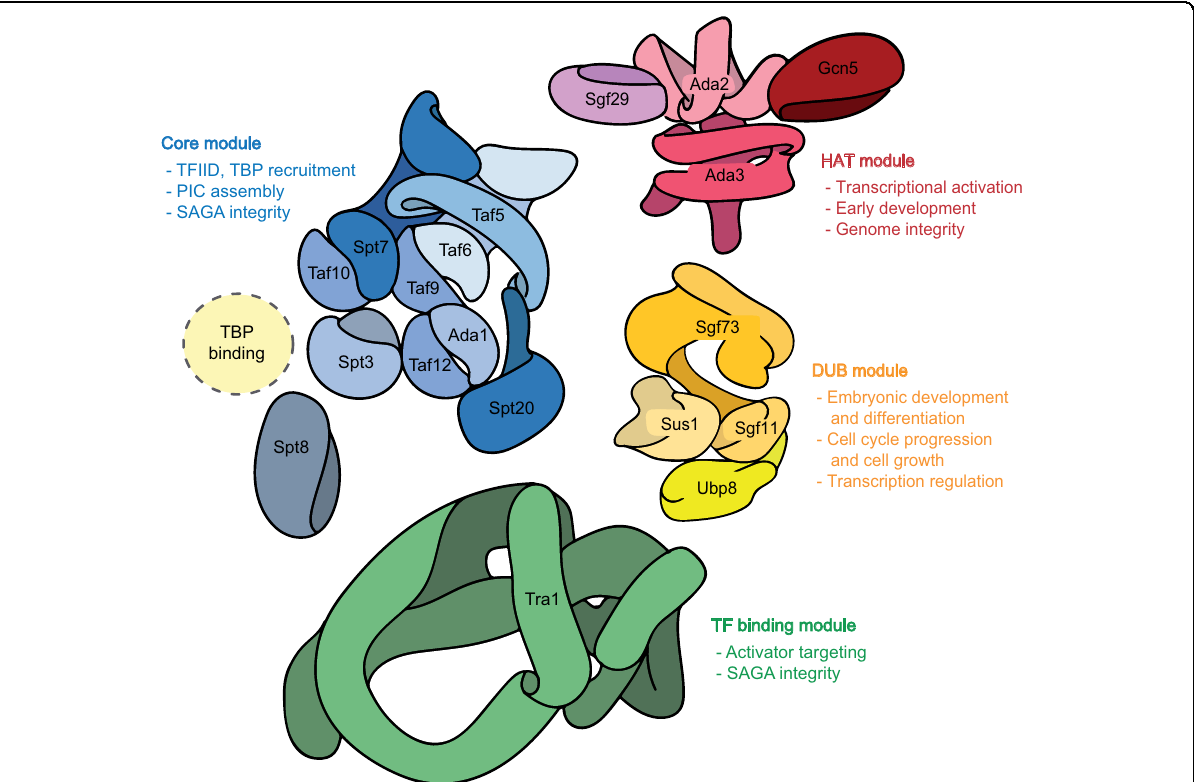
Fig. 1 Schematic diagram showing the modular organization of the SAGA complex. For the sake of simplicity, each subunit is labeled with the name used in S. cerevisiae . The schematic diagram shows the major functions of each module and presents recent structural data obtained from yeast 49,53,64 . Subunits belonging to each module are colored similarly: red, HAT module; blue, core module; green, TF-binding module; and yellow, DUB module. Subunits having a histone octamer-like fold in the core module are depicted as half circles that form circles with their corresponding partners: Taf6-Taf9; Ada1-Taf12; Spt7-Taf10; and Spt3, which has two octamer-like folds. The dotted circle near Spt3 and Spt8 indicates the TBP- binding site, where TBP is recruited at the transcription initiation